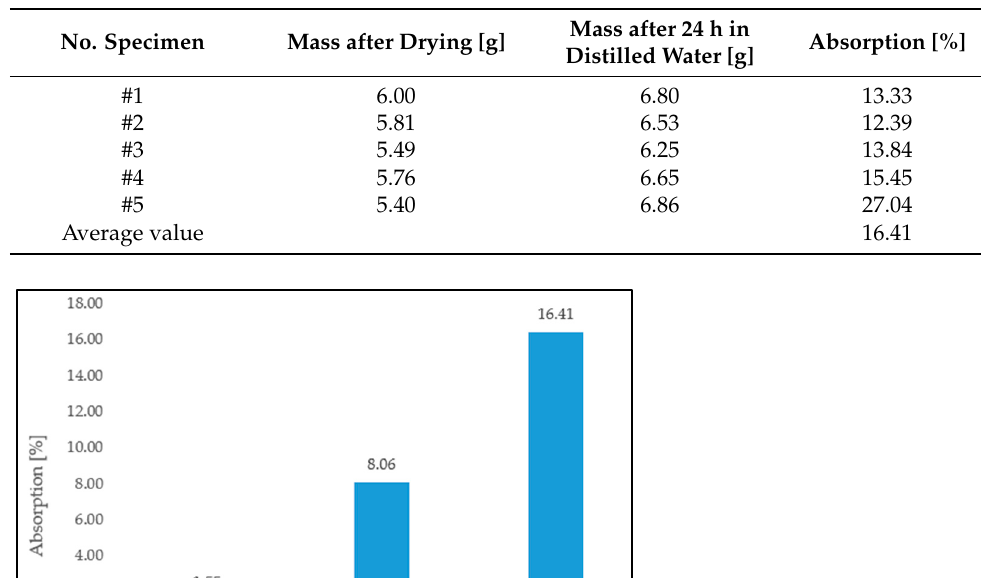
Table 4. Cooling oil absorption of Ecoflex 00-30 test specimens.